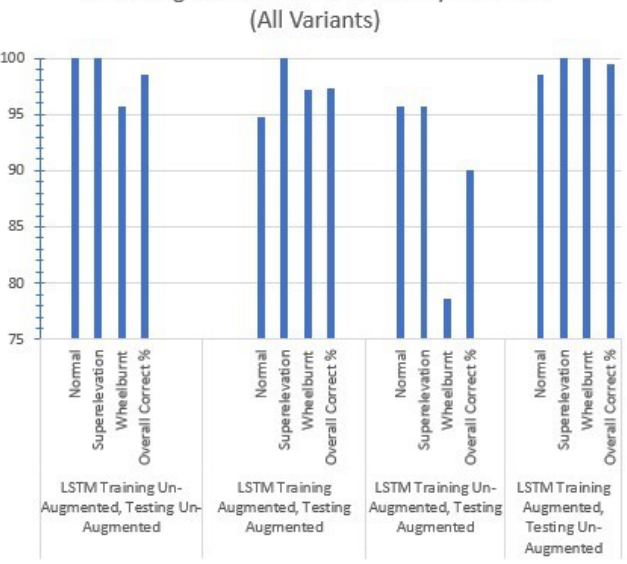
Figure 8. Percentage of correct predictions made by all variants of LSTM with 8.5 s split